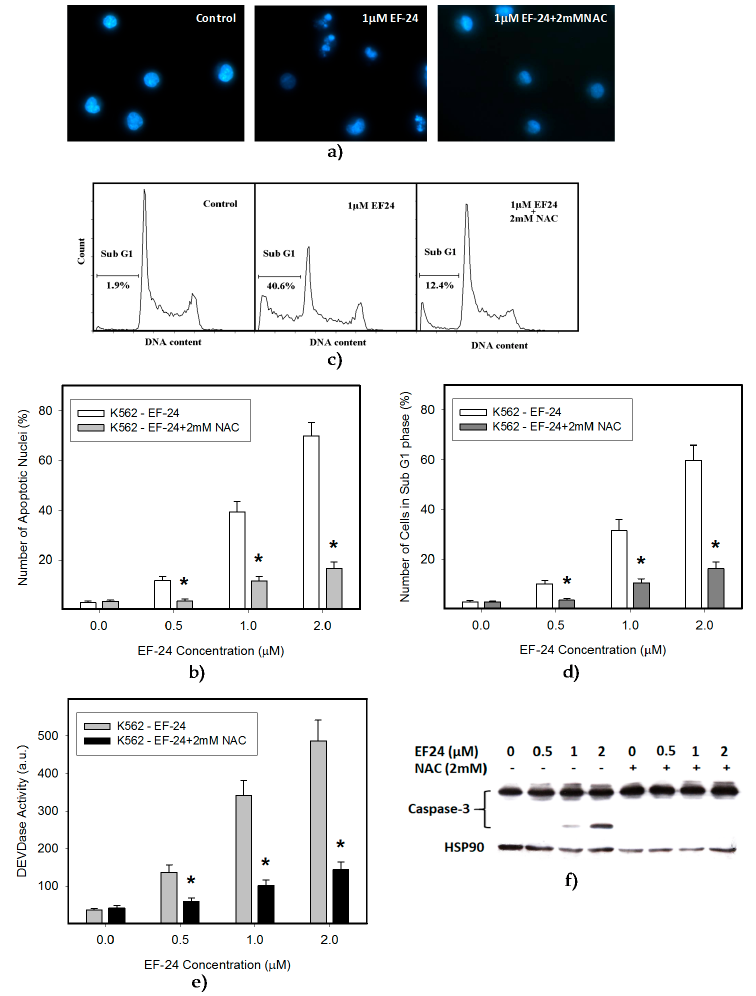
Figure 1. Effect of N -acetylcysteine (NAC) on cell death in 3,5-bis[(2-fluorophenyl)methylene]-4- piperidinone (EF-24)-treated cells. Cells were treated with EF-24 or with EF-24 + 2 mM NAC, as indicated. Incubation proceeded for 24 h prior to appropriate analysis. The experimental points represent mean values from three replicate experiments, with standard deviations. ( a ) Effect of NAC on nuclear morphology in EF-24 treated cells. Pictures represent typical examples. ( b ) A quantitative analysis of the effect of NAC on nuclear morphology in EF-24 treated cells. At least 300 cells were examined in each experiment; * denotes significant change in the number of cells with apoptotic nuclei ( p < 0.05) between K562 cells treated with EF-24 and cells treated with EF-24 + NAC. ( c ) Effect of NAC on occurrence of cells in sub G1 phase in response to EF-24 treatment. A representative analysis. ( d ) A quantitative analysis of the effect of NAC on occurrence of cells in sub G1 phase in response to EF-24 treatment; * denotes significant change in the number of cells sub G1 phase ( p < 0.05) between K562 cells treated with EF-24 and cells treated with EF-24 + NAC. ( e ) Effect of NAC on caspase-3 activation in EF-24-treated cells. After 16 h, cells DEVDase enzymatic activity was determined in cell lysates using Ac-DEVD-AMC; * denotes significant change in DEVDase enzymatic activity ( p <0.05) between K562 cells treated with EF-24 and cells treated with EF-24 + NAC. ( f ) Effect of NAC on caspase-3 processing in EF-24 treated cells. After 16 h, caspase-3 processing was monitored using western blot analysis. Picture represents a typical example.